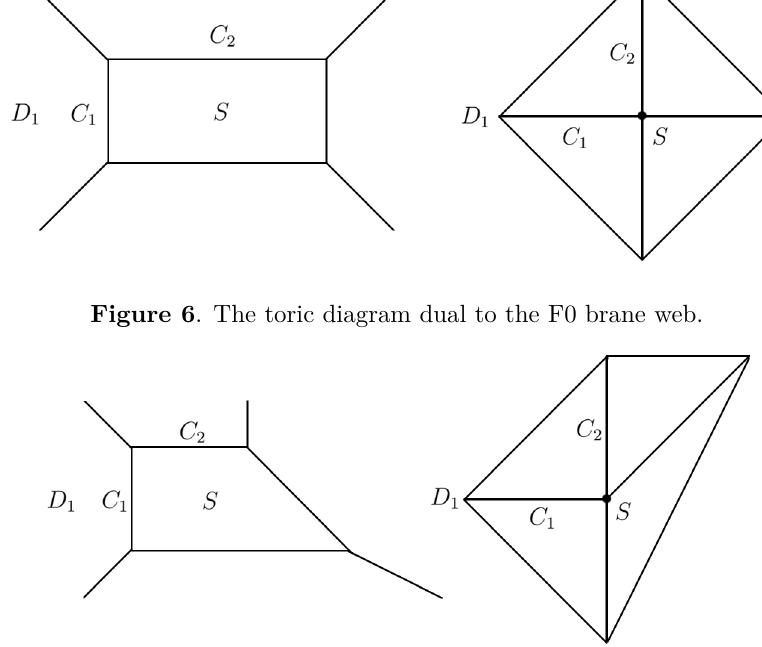
Figure 7 . The toric diagram dual to the F1 brane